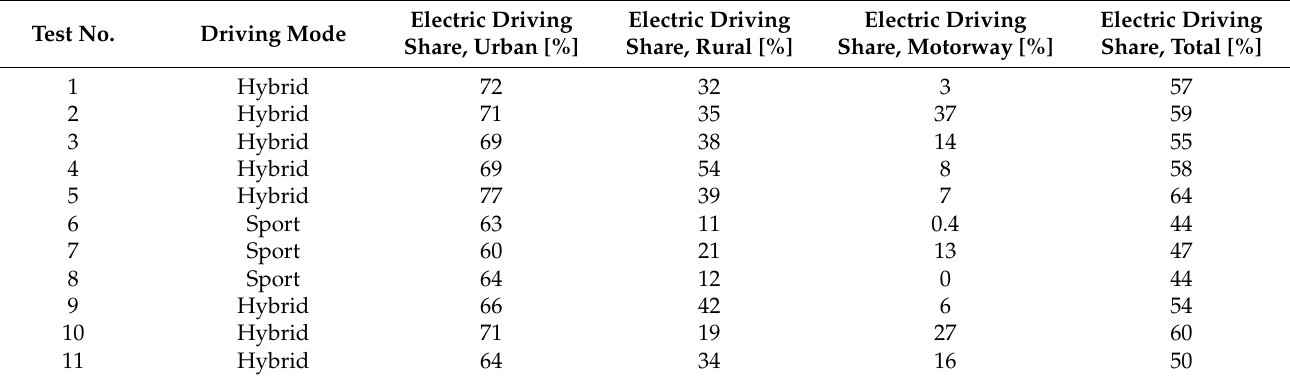
Table 4. Overview of the PHEVs electric diving shares in the real-world driving